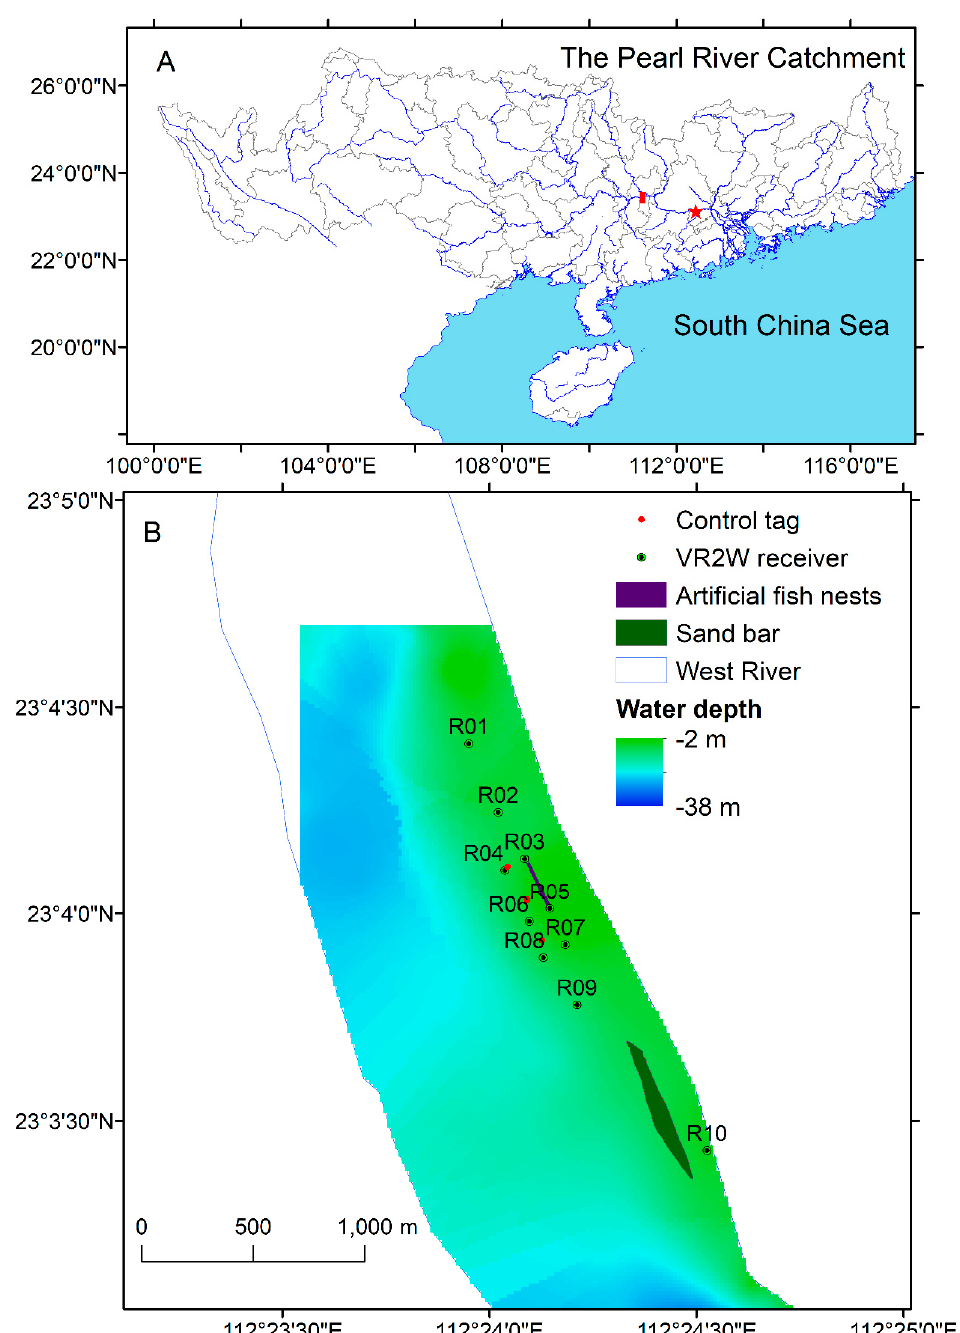
Figure 1. The study area was located in the downstream region of the Pearl River, shown by the red star, and the Changzhou hydrojunction (the red elongated rectangular mark) was located in the midstream ( A ); The locations of control tags, VR2W receivers, and habitats including artificial fish nests and the sand bar, and water depth in the study area are shown in ( B ).